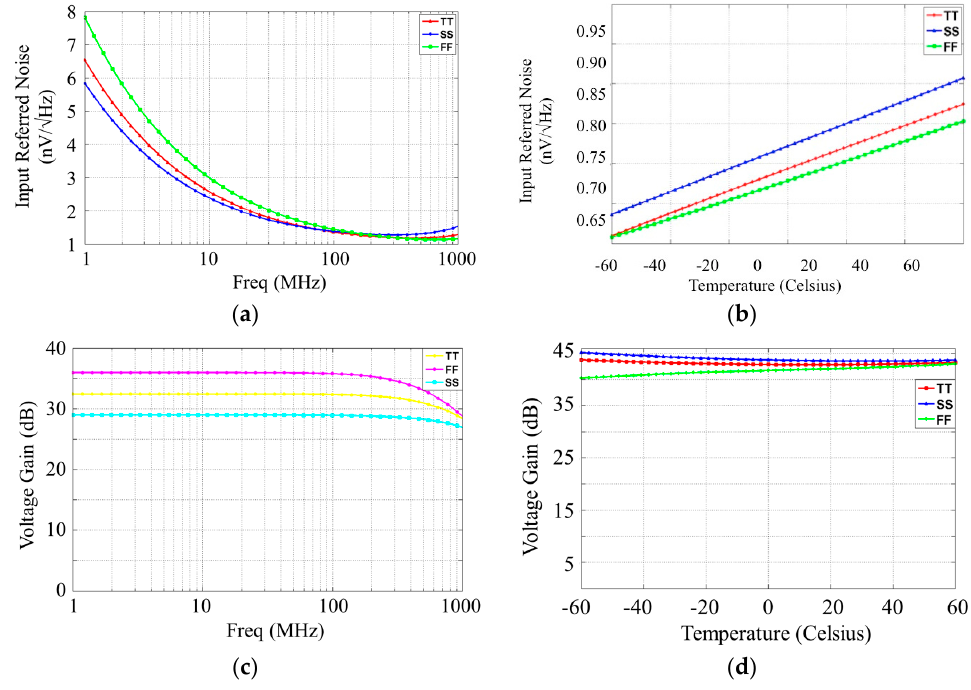
Figure 9. Simulated input referred noise of the ( a ) LNA over frequency and ( b ) the LC-LNA over temperature at 300 MHz for three fabrication process corners; Simulated voltage gain of the ( c ) LNA over frequency and ( d ) the LC-LNA over temperature at 300 MHz for three fabrication process corners.